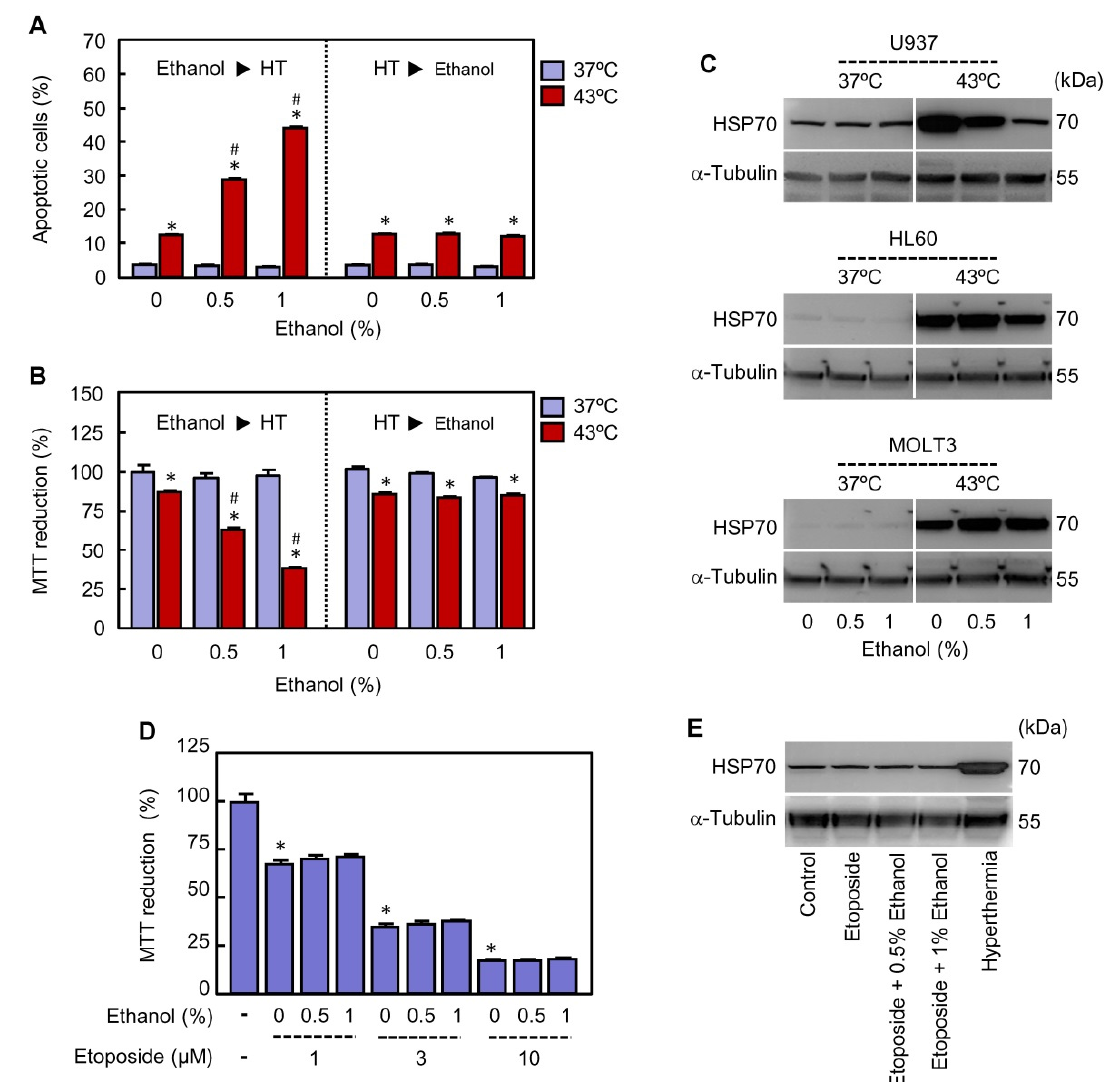
Figure 6. Impact of the moment of ethanol addition on modulation of cell death triggered by hyperthermia (HT) and role of HSP70. ( A , B ) U937 cells were treated with the indicated concentrations of ethanol before (Ethanol ► HT, left panel) or after (HT ► Ethanol, right panel) they were immersed for 30 min in a water bath at 37 °C or 43 °C, as indicated. ( A ) The cells were incubated at 37 ºC for 3 h of recovery and the percentage of apoptotic cells determined by flow cytometry using the propidium iodide staining procedure. ( B ) The cells were incubated at 37 °C for 24 h of recovery and the mitochondrial activity determined at 570 nm by the MTT reduction assay using a microplate reader. ( C ) The cells were exposed to hyperthermia (30 min at 43 °C) in presence of the indicated concentrations of ethanol and allowed to recover at 37 °C for 3 h (U937) or 8 h (HL60 and MOLT3). Whole cell lysates were prepared and levels of HSP70 analyzed by immunoblotting; as a loading control, α -tubulin was also determined. ( D ) U937 cells were incubated with etoposide (1–10 μ M) in presence of the specified concentration of ethanol at 37 °C for 24 h and metabolic activity determined by the MTT reduction assay. ( E ) U937 cells were incubated with etoposide (10 μ M) in absence or presence of the specified concentration of ethanol for 6 h and the expression of HSP70 determined by immunoblotting; as a loading control, α -tubulin was also included. * p < 0.05 vs. respective control; # p < 0.05 vs. hyperthermia (43 °C) treatment alone.